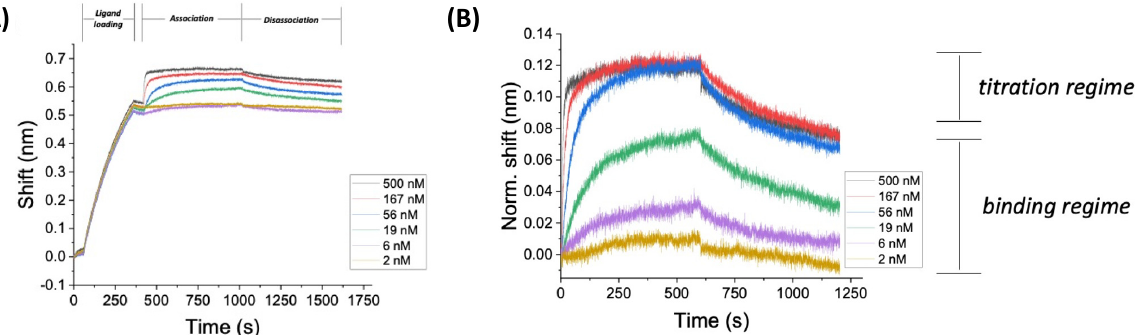
Figure 9. BLI sensorgrams for ACE2xDELTA in bicarbonate buffer at 30 ◦ C. ( A ) Representative sensogram for ACE2xDELTA in bicarbonate buffer at 30 ◦ C. Regions of ligand loading, analyte association, and disassociation are indicated at the top of the time series plot. The assay was conducted over concentrations that span the binding regime and the titration regime. ( B ) Association and dissociation curve for DELTA using [biot]ACE2 on SAV-coated fibers as the ligand in bicarbonate buffer at 30 ◦ C.